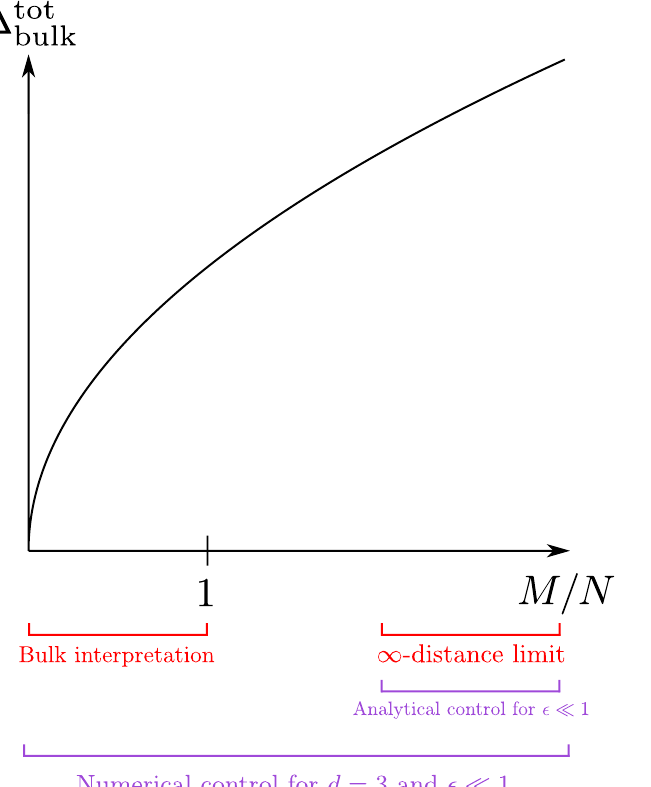
√ Figure 8 . The power-like behavior ∆ ∼ M , or at least ∆ ∼ M α with α ≈ 0 . 5 , persists down to small steps M . N , where a bulk description is more reliable due to the absence of the extra constraints discussed in section 6 (see also [138]). The analytic control given by the (cid:15) -expansion provides a convenient cross-check, but our ultimate interest is in the case d = 3 , and our numerical technique does not require M (cid:29) N